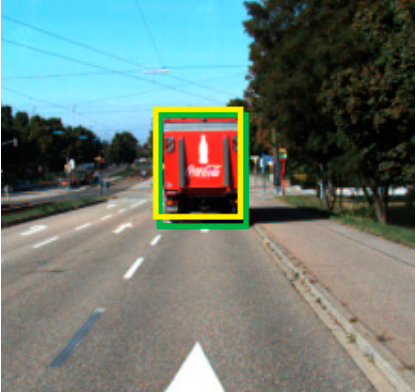
Figure 11. Camera (green bounding box) and transformed LiDAR bounding box (yellow) imposed in the 2D space.